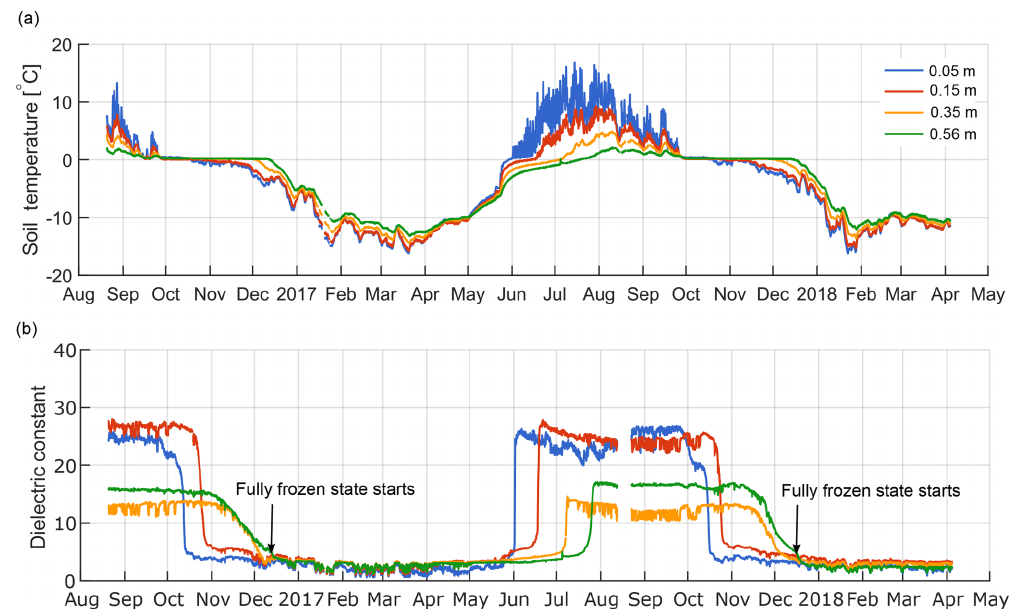
Figure 3. In situ measurements of soil temperature (a) and dielectric constant (b) for a single SoilSCAPE sensor node (S6) at the Prudhoe Meadow site in northern Alaska (http://soilscape.usc.edu, last access: 1 May